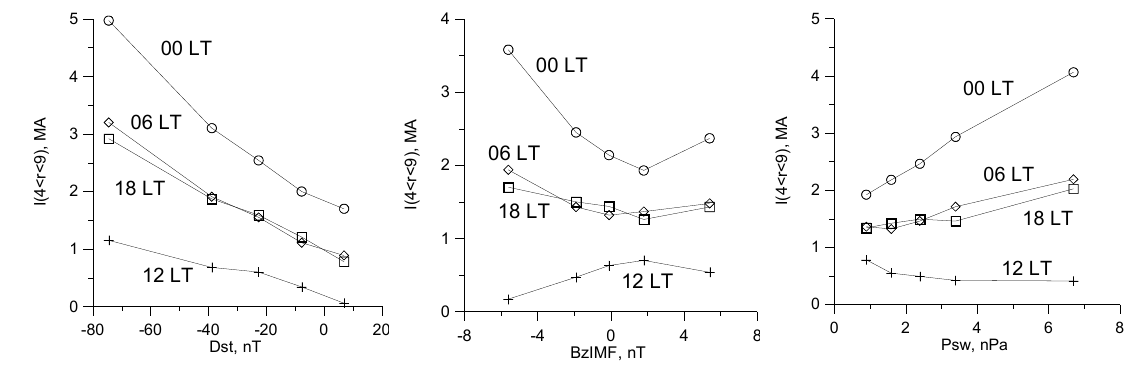
Fig. 3. Total current flowing at radial distances from 4 to 9 R E versus (left) D st , (middle) B z IMF, and (right) P sw in four LT sectors.